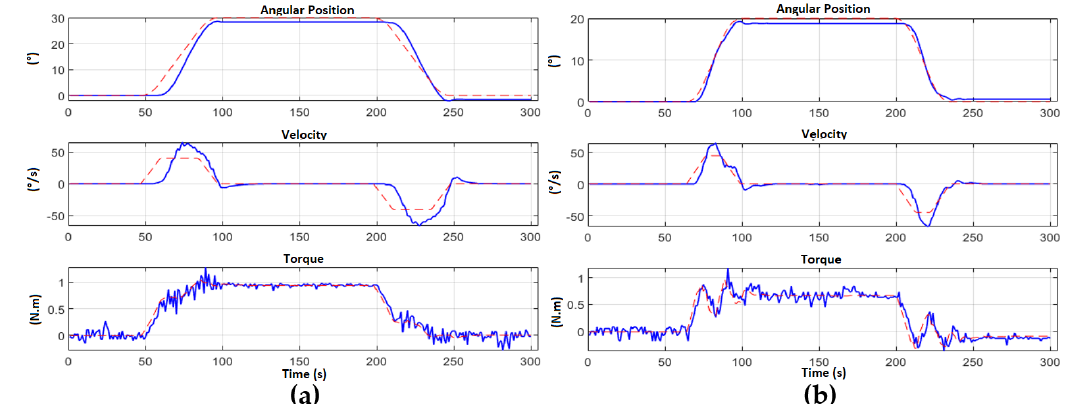
Figure 28. Position, speed and torque of each motor of the teleoperator robot head. ( a ) Motor 1 from 0 ◦ to 30 ◦ ; ( b ) Motor 2 from 0 ◦ to 20 ◦